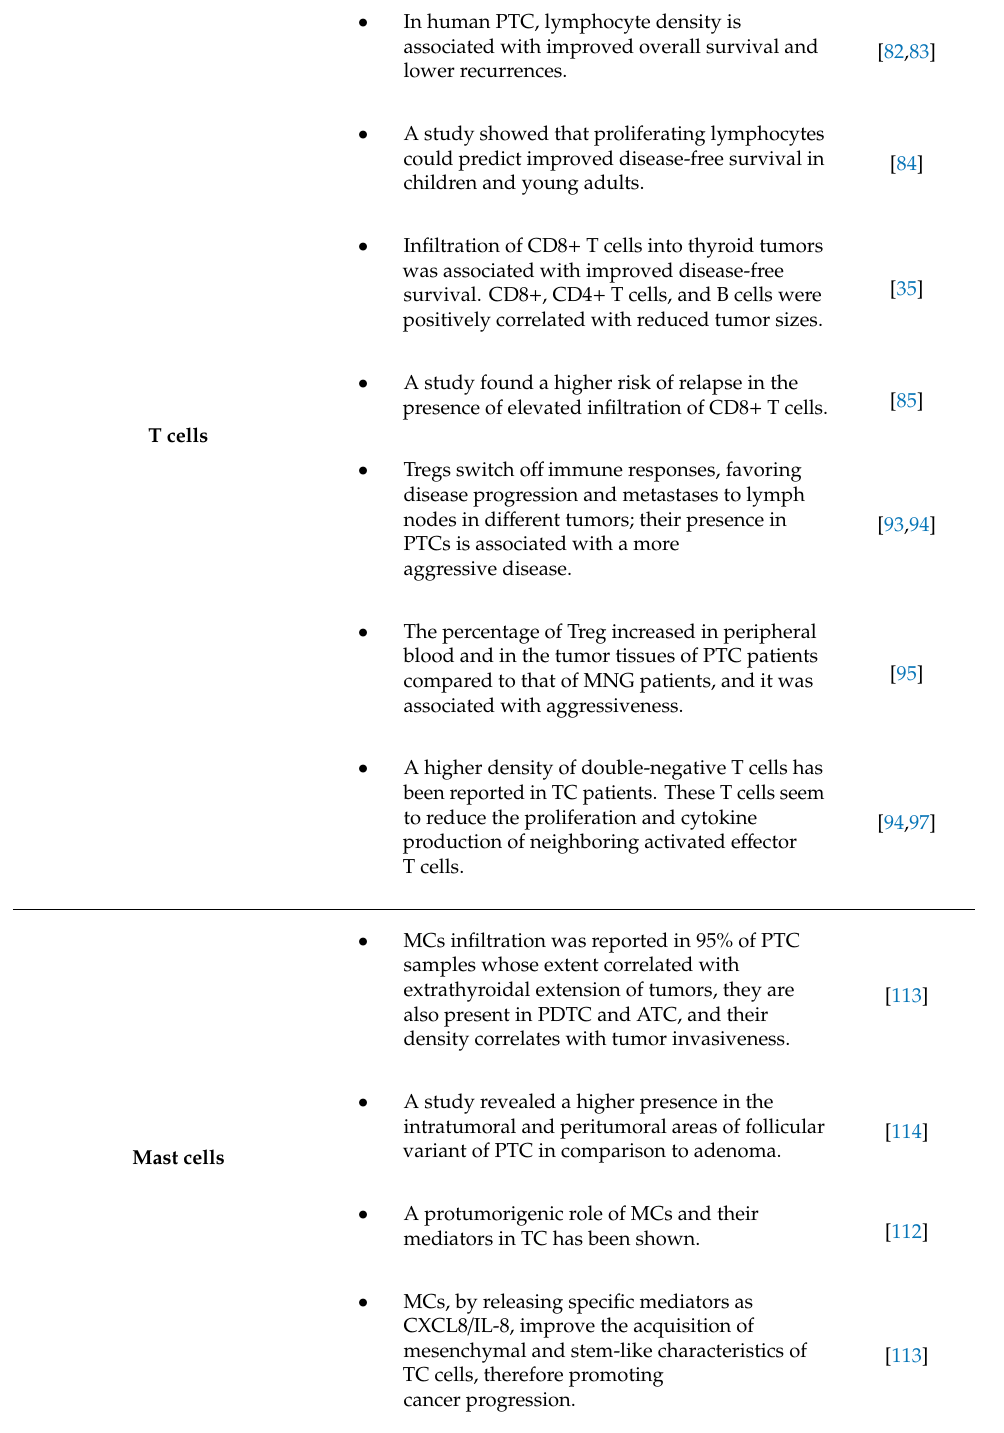
Immune Cells Reported